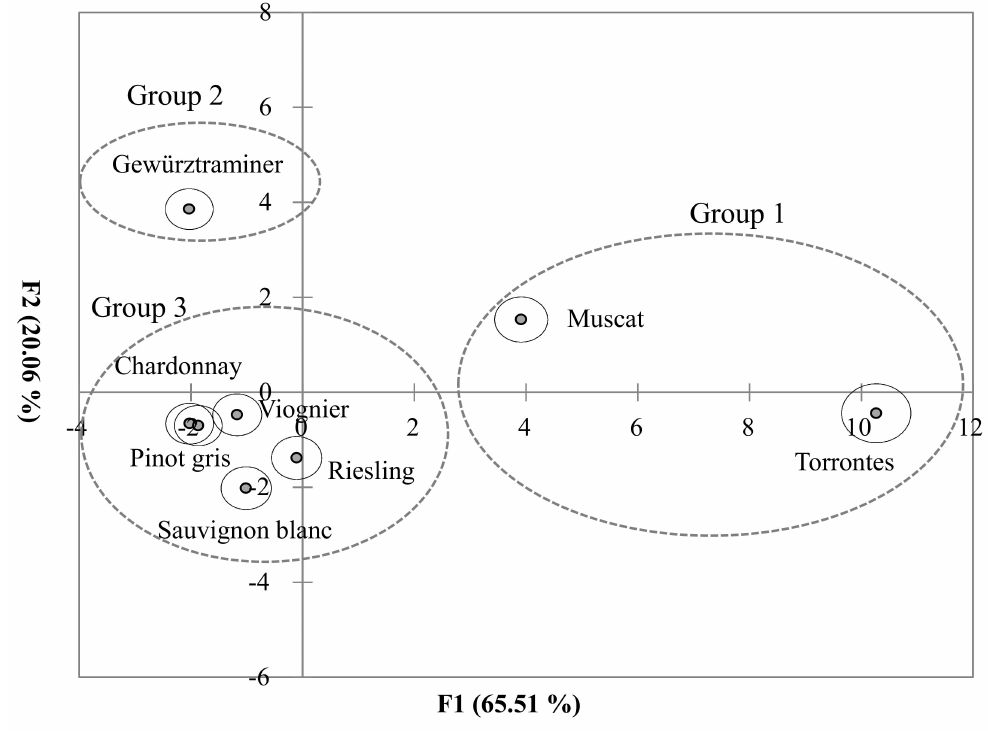
Figure 2. Discriminant plot of varietal wines on concentration of monoterpene isomers. Varietal wine scores were represented by centroids surrounded by 95% confident regions (the solid circle). Three groups were separated by the dashed